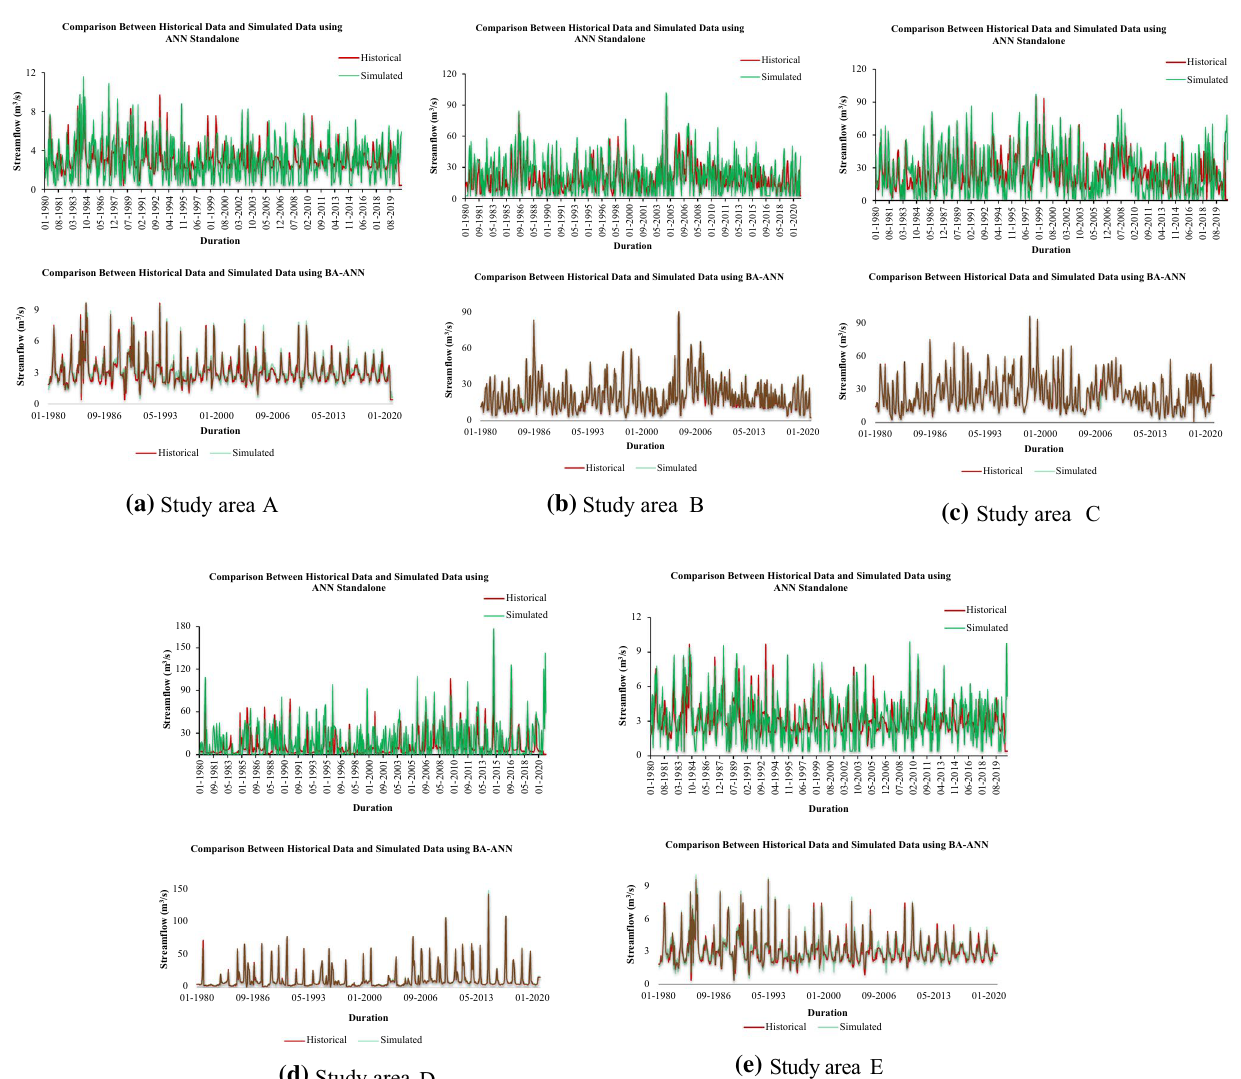
Fig. 4 Streamflow simulation and forecast for all study areas